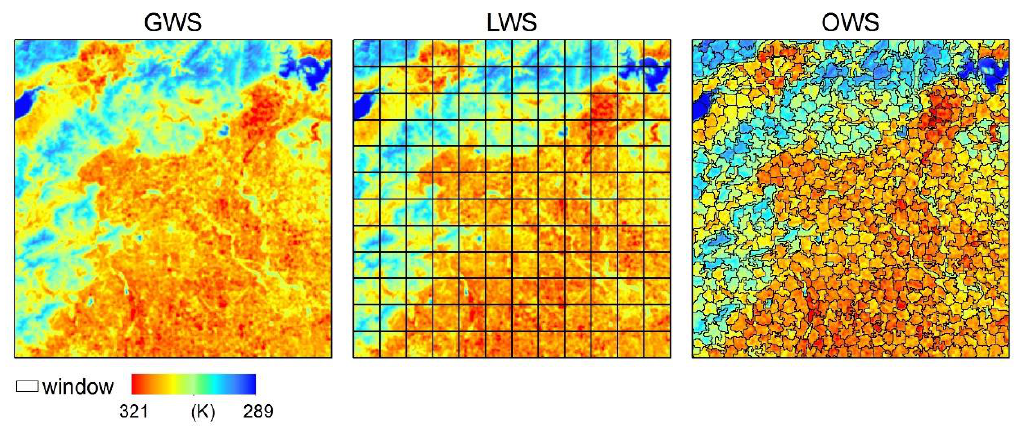
Figure 1. Window strategies. The background image is a 100 m-resolution LST derived from Landsat 8 data.